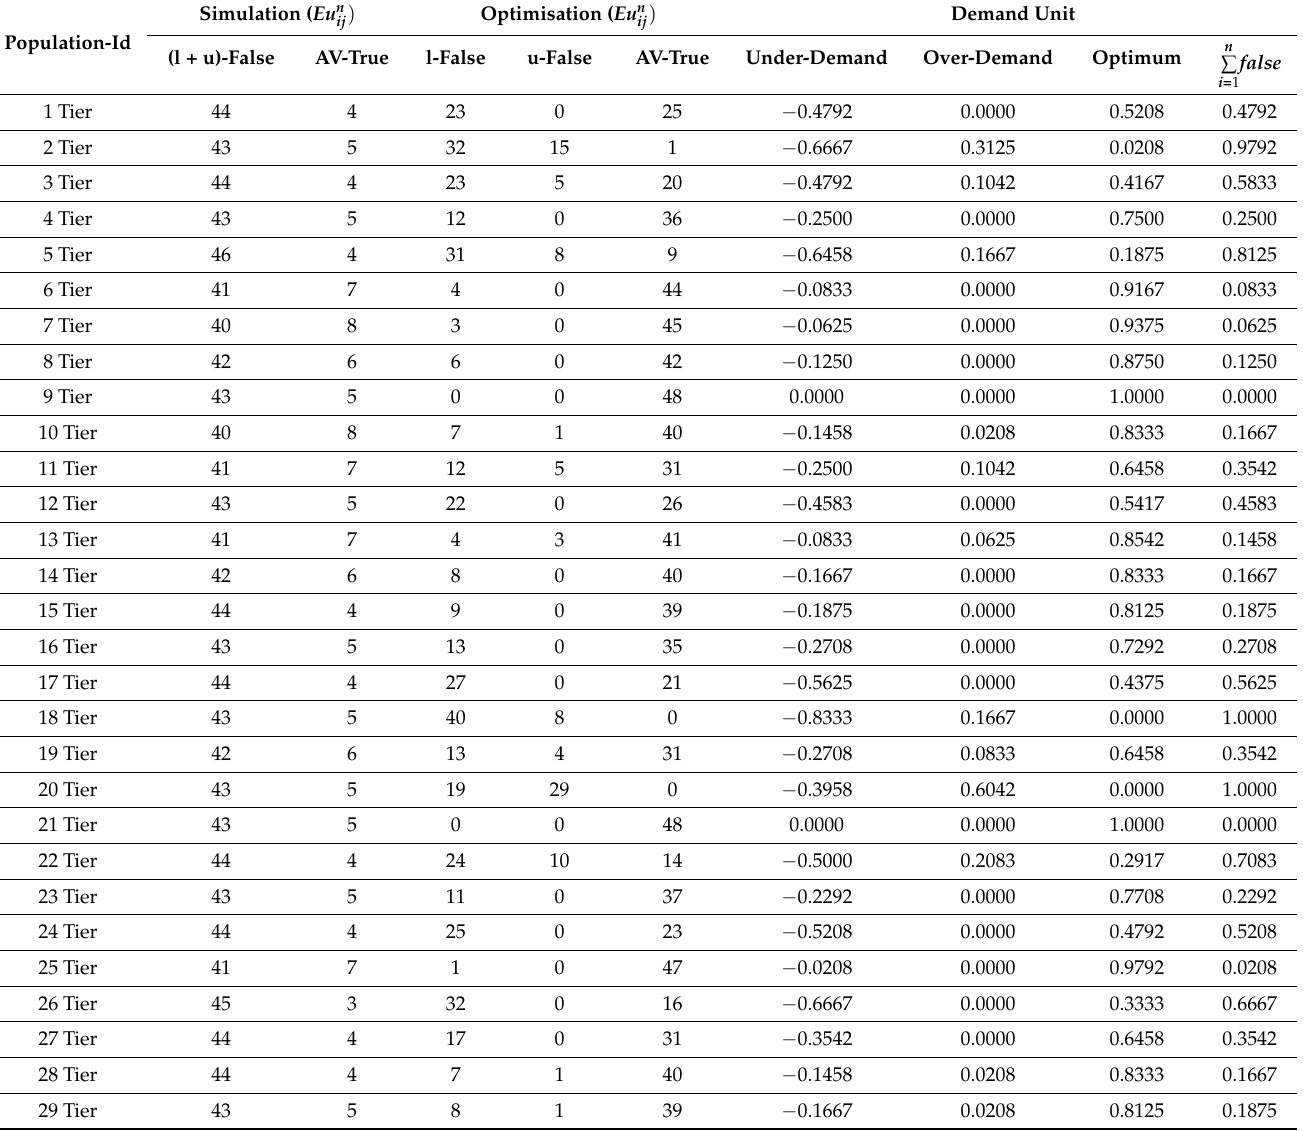
Table 4. Data Simulation and Optimisation